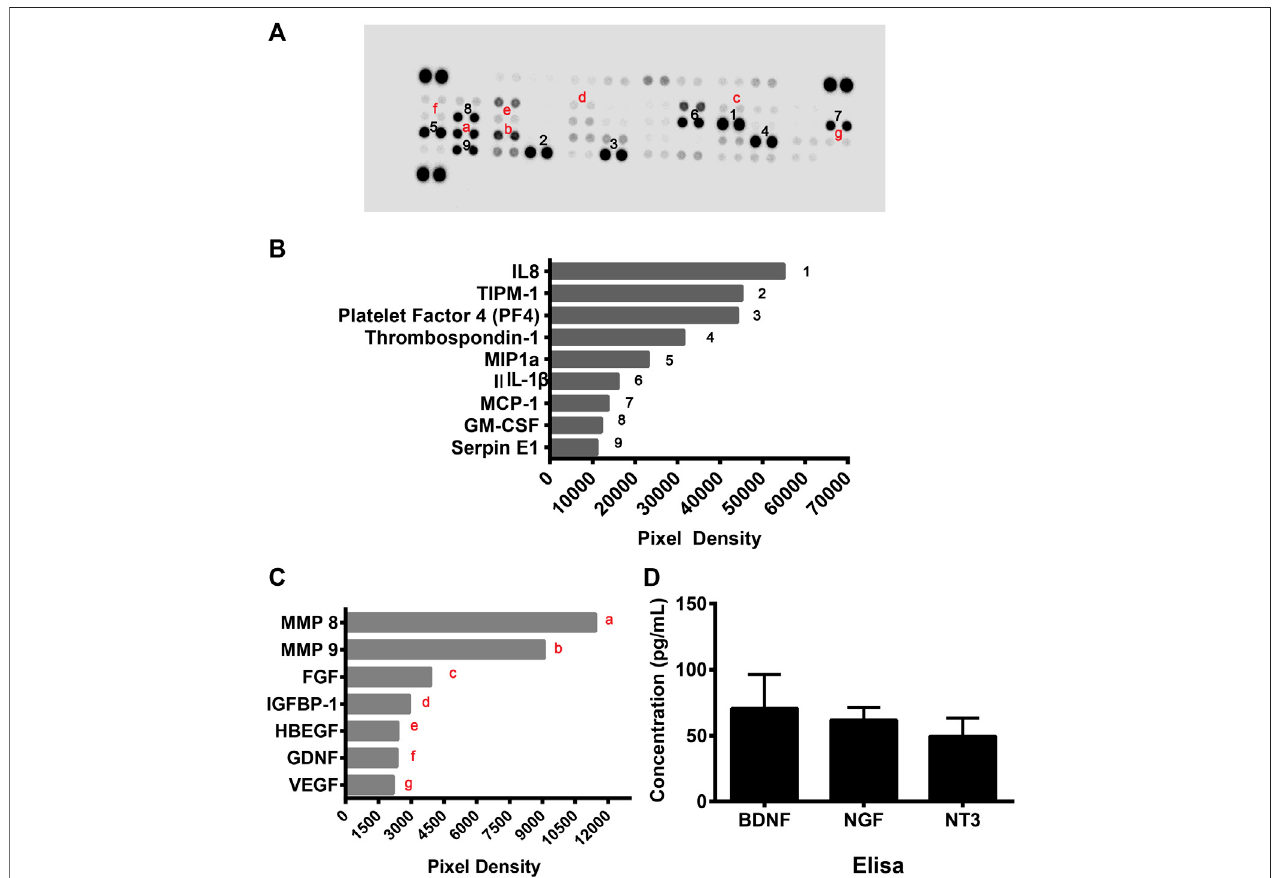
FIGURE 7 | CD133 + CD34 + cell supernatant mediated angioprotective and neurotrophic effect. (A) : Human angiogenesis protein array was used to pro fi le angio- rassociated proteins in the CD133 + CD34 + cell supernatant secretome. (B) : The top 9 highly expressed factors in the CD133 + CD34 + cells. (C) : The secretome from the CD133 + CD34 + cells contained angio-associated factors. (D) : ELISA revealed the concentration of neurotrophic factors in CD133 + CD34 + cell supernatant.